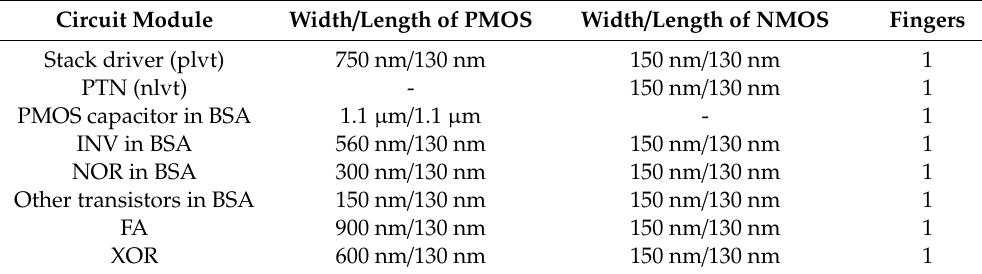
Table 1. The sizing of different parts in the proposed adder circuit.